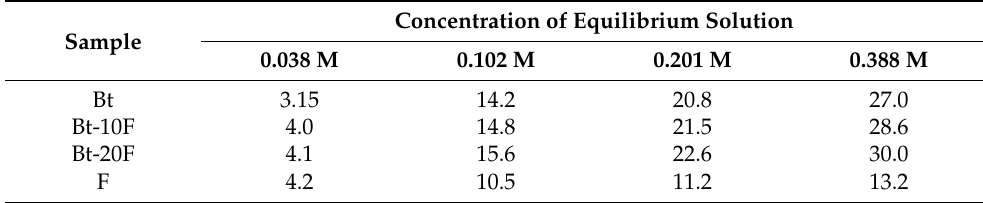
Table 3. Adsorption capacity (mg/g) of bentonite, cobalt ferrite and composites on their base towards formaldehyde in aqueous solutions of various concentrations (20 ◦